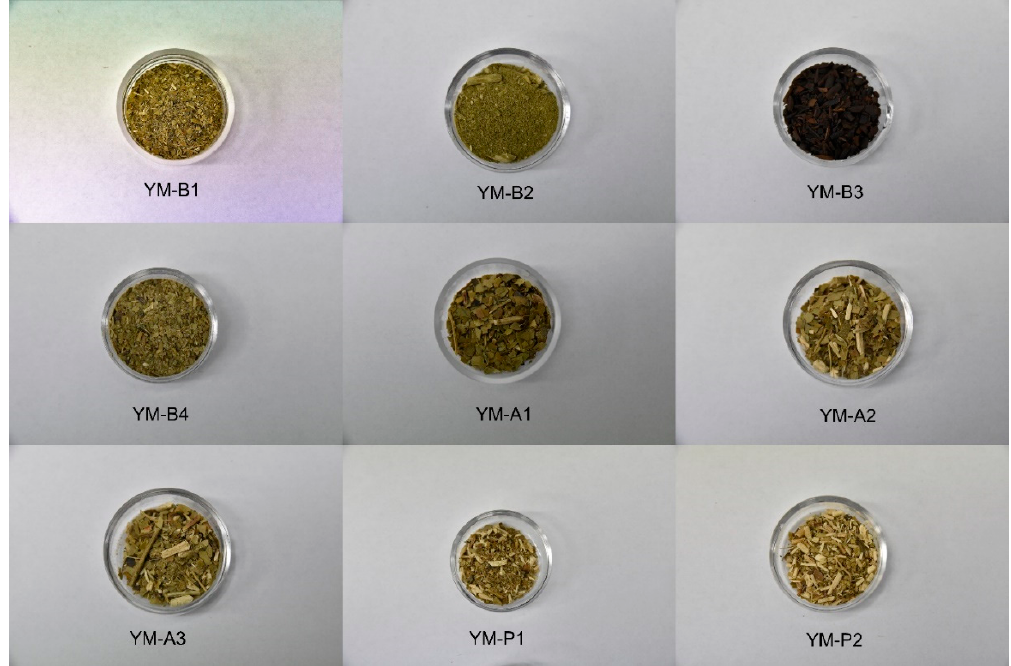
Figure 1. Analyzed products of yerba mate.